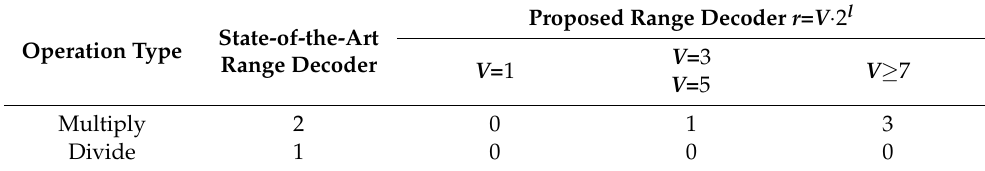
Table 6. Number of multiplication and division operations per decoded symbol for Total = 2 w 3 .